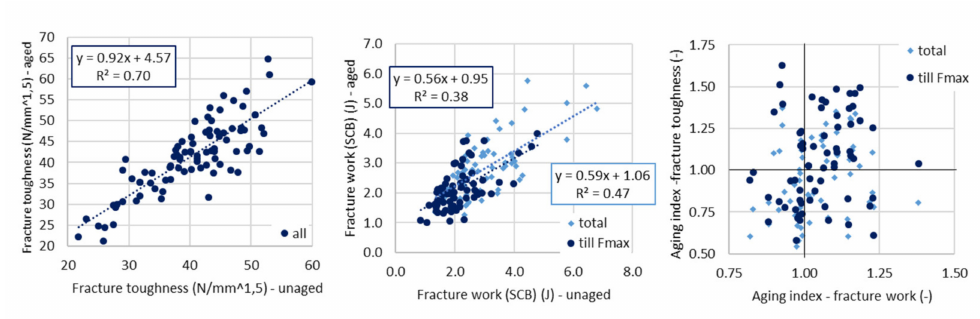
Figure 6. Comparison of aged and virgin parameters—semi-circular bending (SCB) test ( left and middle ) and comparison of aging indexes ( right